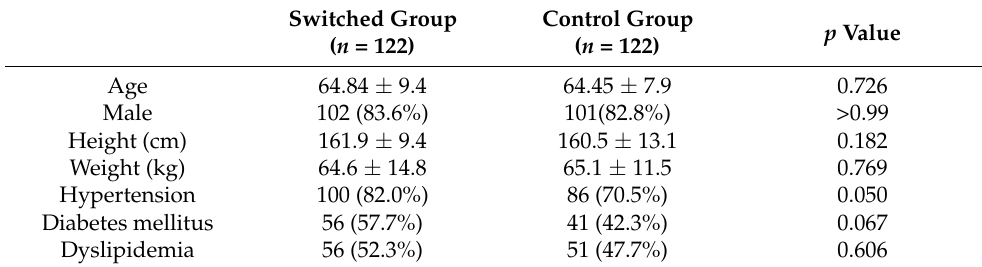
Table 1. Baseline characteristics of the patients.